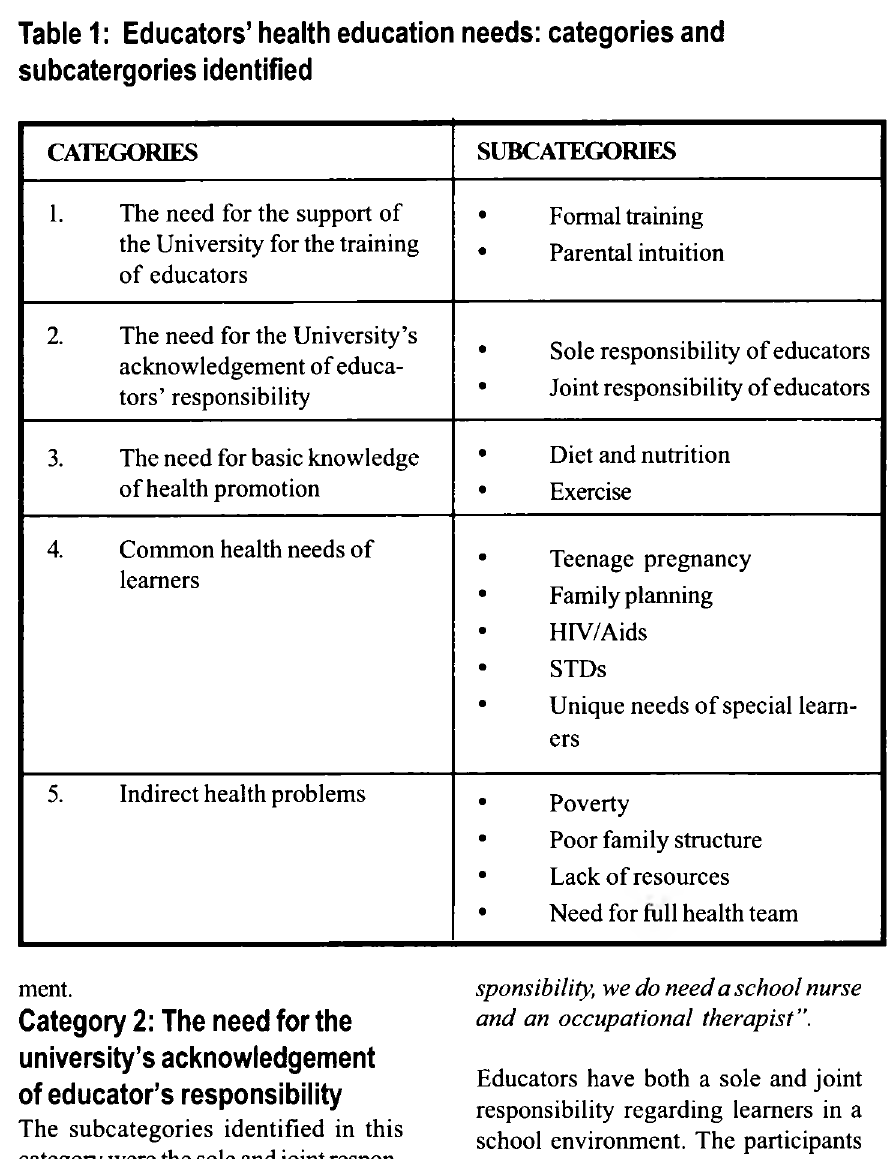
Table 1: Educators’ health education needs: categories and subcatergories